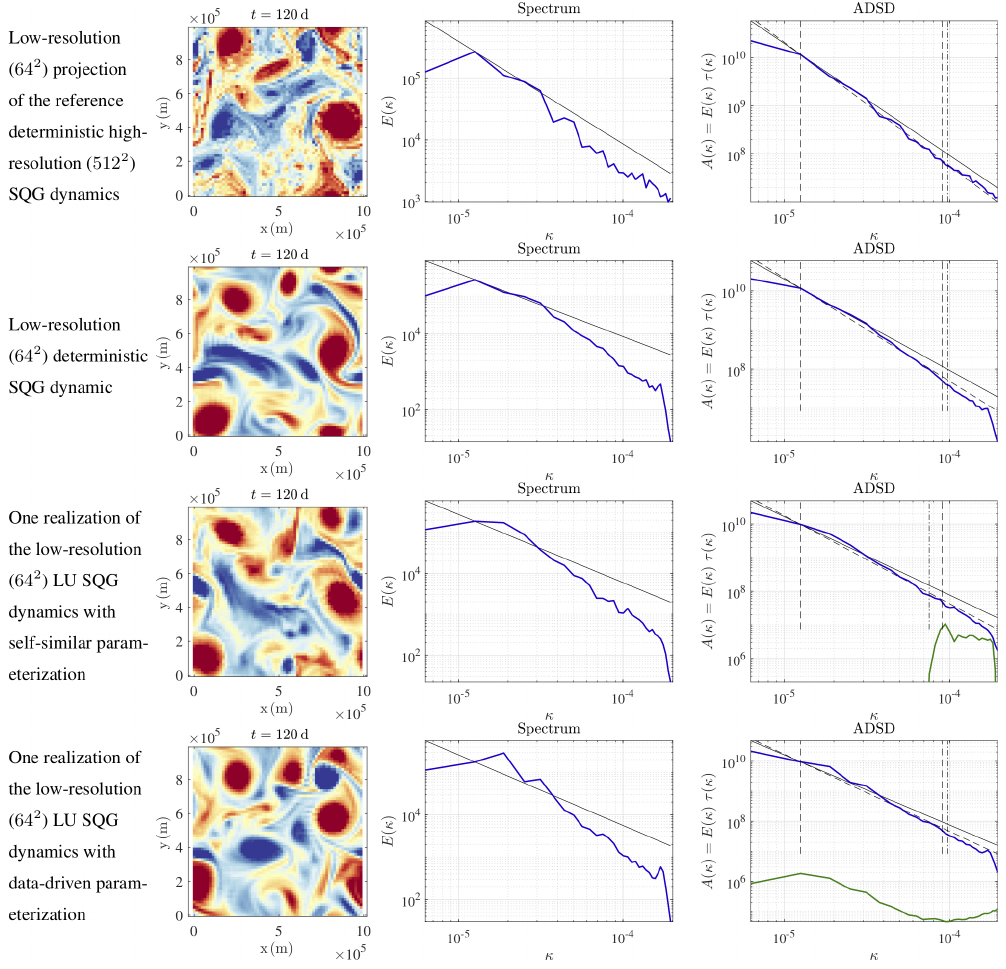
Figure 10. Buoyancy fields (ms − 2 ) (left); kinetic energy spectra (m 2 s − 2 / (radm − 1 )) (middle); and ADSDs (m 2 s − 1 / (radm − 1 )) (right) of w , in blue, and ADSDs of σ ˙ B , in green, at t = 120d, for (from top to bottom) the low-resolution (64 2 ) projection of the reference deterministic high-resolution (512 2 ) SQG dynamics, the low-resolution (64 2 ) deterministic SQG dynamic, one realization of the low-resolution (64 2 ) LU SQG dynamics with self-similar parameterization, and one realization of the low-resolution (64 2 ) LU SQG dynamics (equivalent to SALT SQG) with data-driven